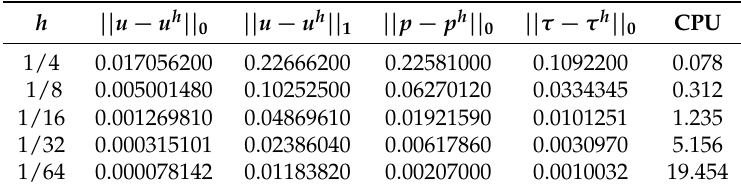
Table 1. The error results with standard FE P 1 b - P 1- P 1.